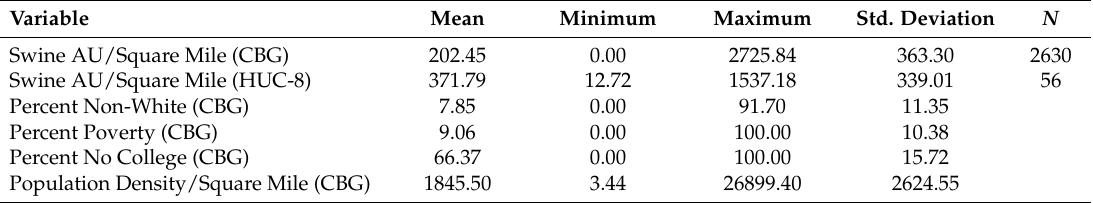
Figure 6. Spatial distribution of EJ covariates percent non-white residence ( A ); percent residents living in poverty ( B ); percent no college degree ( C ); and population density ( D ) in Iowa CBGs. Urban areas are outlined in red. Table 1. Descriptive statistics for swine density and EJ variables in Census Block Groups and